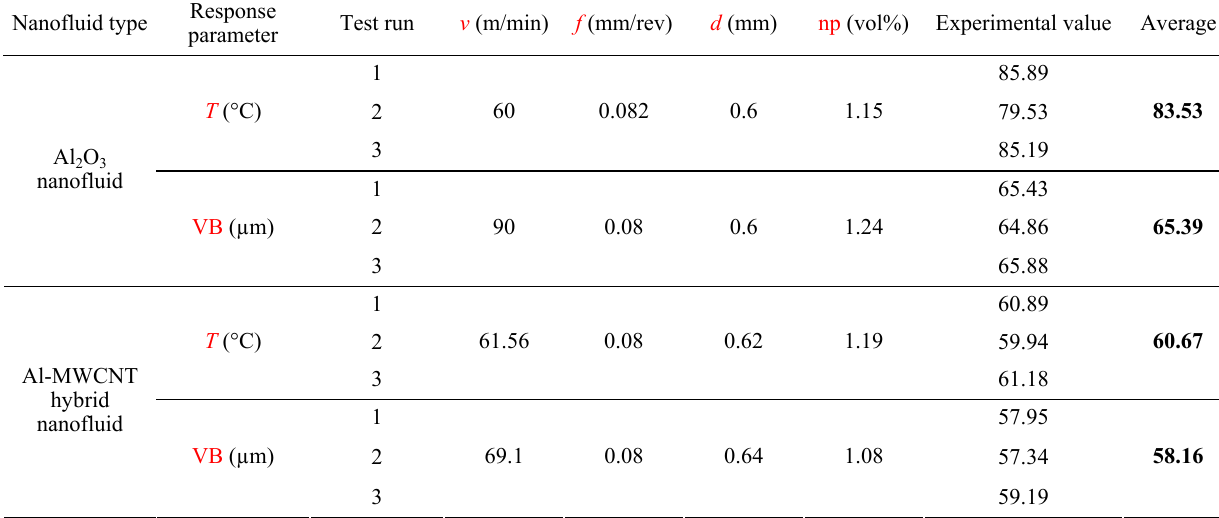
Table 8 Responses of validation experiments for Al2O3 and Al-MWCNT